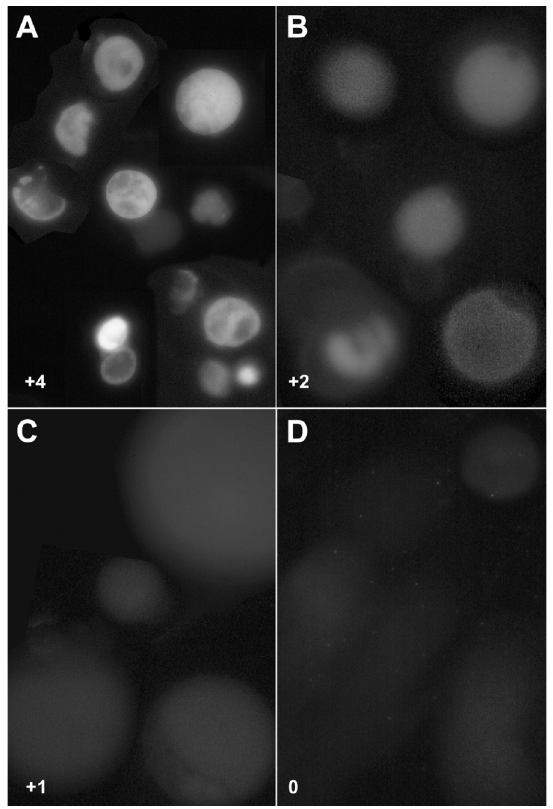
Figure 5. Annexin V-FITC binding to multilamellar archaeosomes composed of the total polar lipids from M. smithii (A), M. jannaschii (B), M. mazei (C) and H. halobium (D). Calcium-dependent binding of annexin V-FITC to multilamellar archaeosomes (about 1 µm in di- ameter) was observed in wet mounts. Relative fluorescence is shown in each